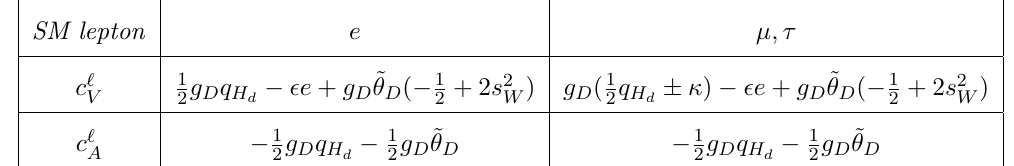
and the minus sign to c (cid:28) . V V